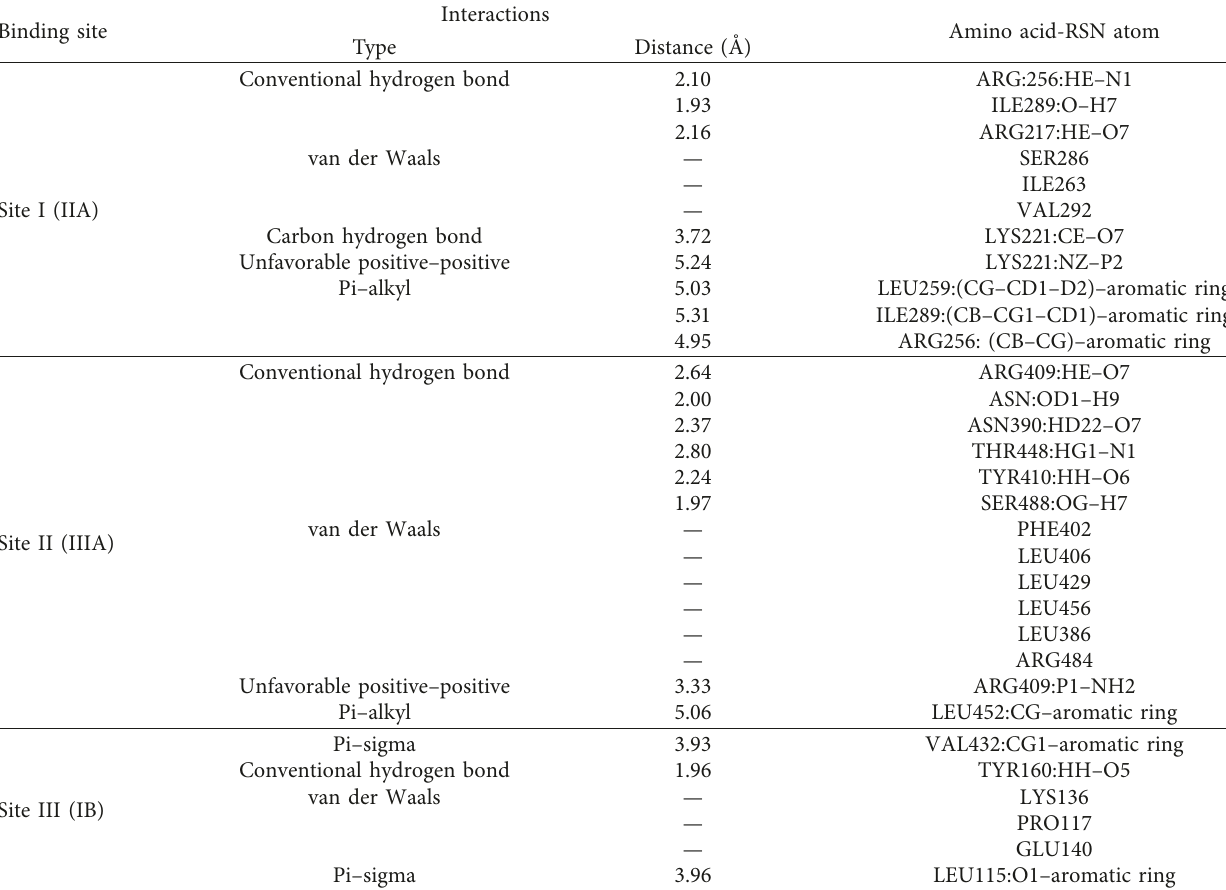
Table 6: Type of interactions, involvement, and their distances between amino acids present in BSA after interaction with RSN for three binding sites by molecular docking